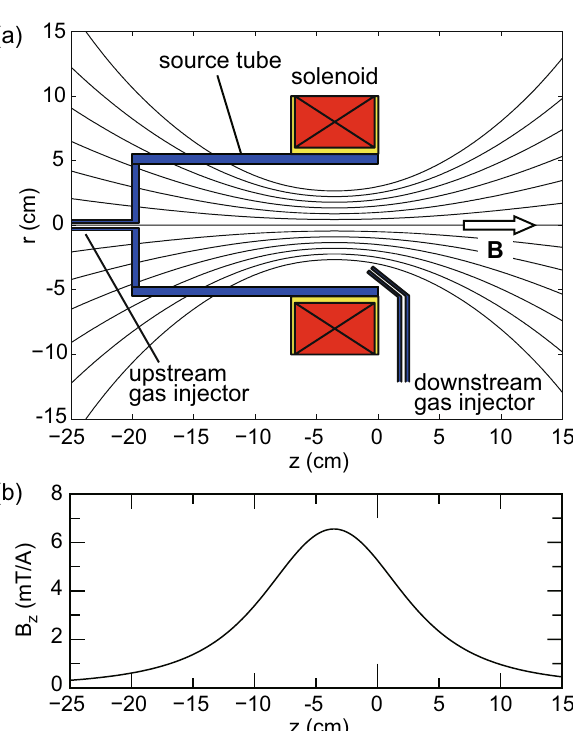
Figure 1. Schematic diagrams of the magnetic nozzle rf plasma thrusters with ( a ) the m 0 mode double-turn loop antenna. antenna and ( b ) the m =